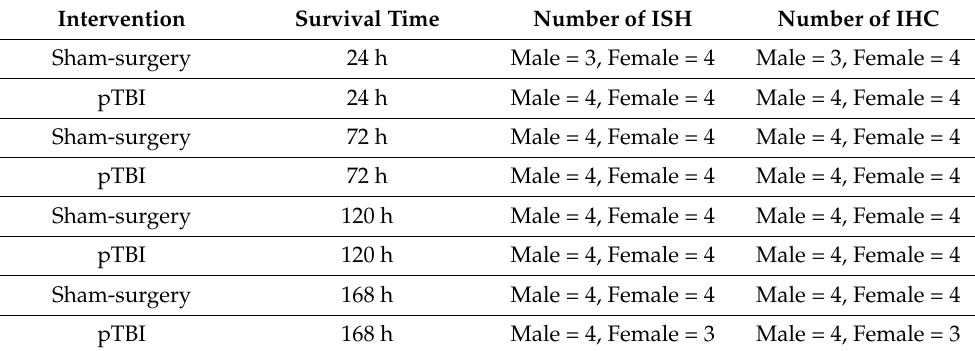
Table 1. Material composition based on sex, survival time and intervention.